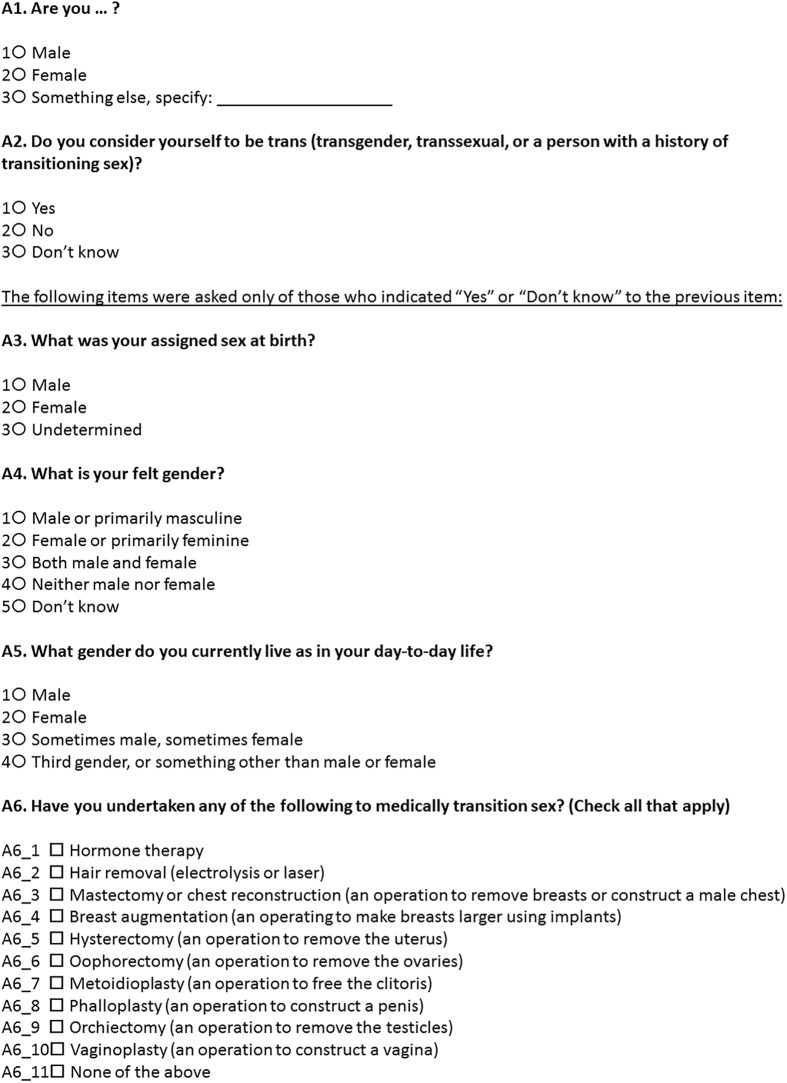
Multidimensional test measure [4].